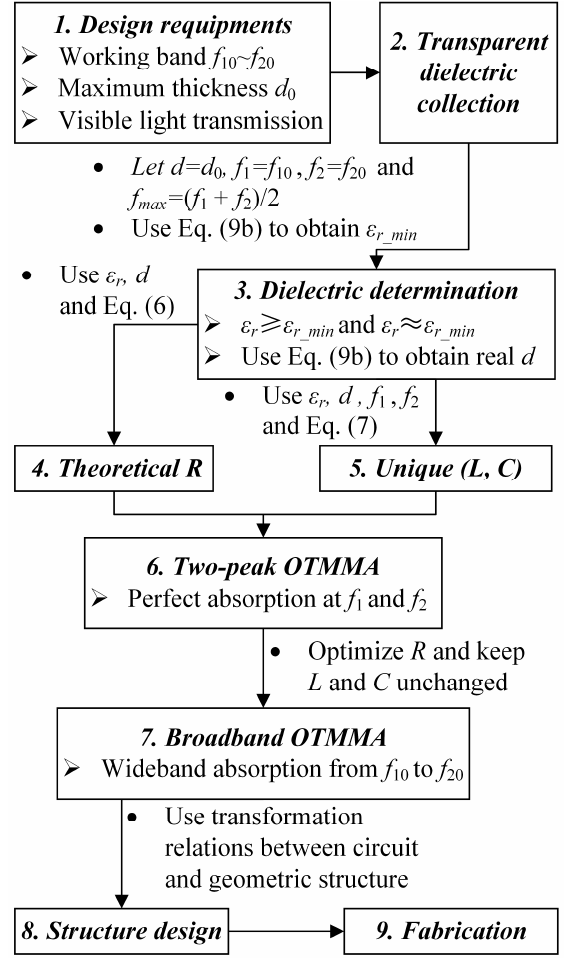
Figure 5. The proposed controllable design approach to